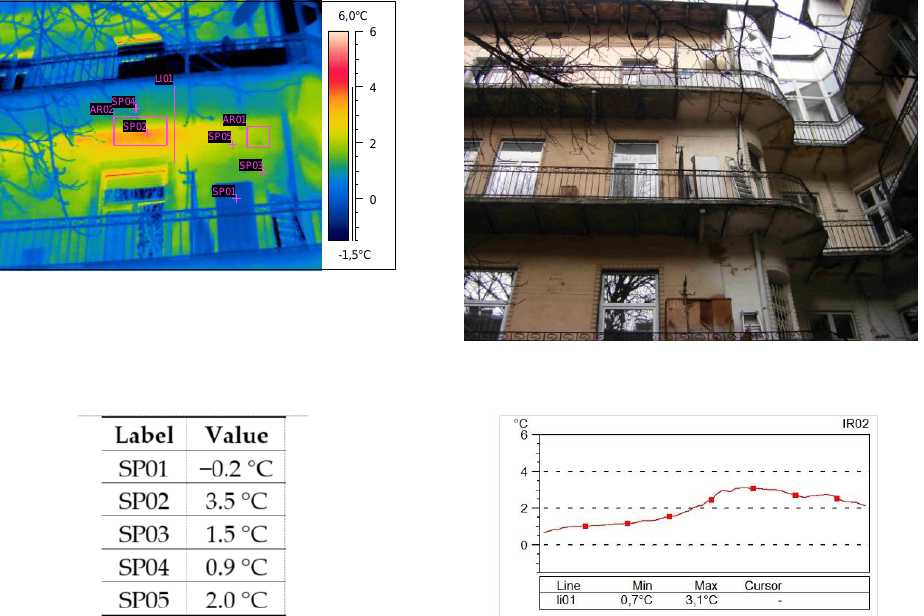
Figure 8. Courtyard-facing facade thermovision diagnostics with measurements.